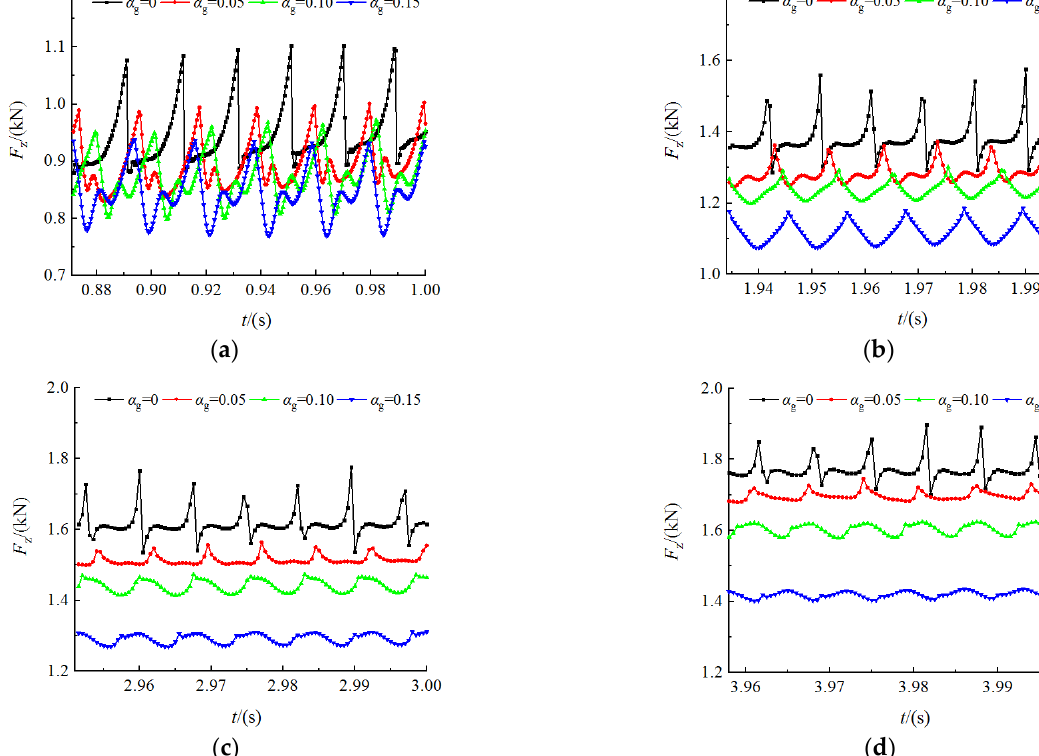
Figure 14. Time domain characteristic of axial force during the start-up process. ( a ) t = 1 s; ( b ) t = 2 s; ( c ) t = 3 s; ( d ) t = 4 s.